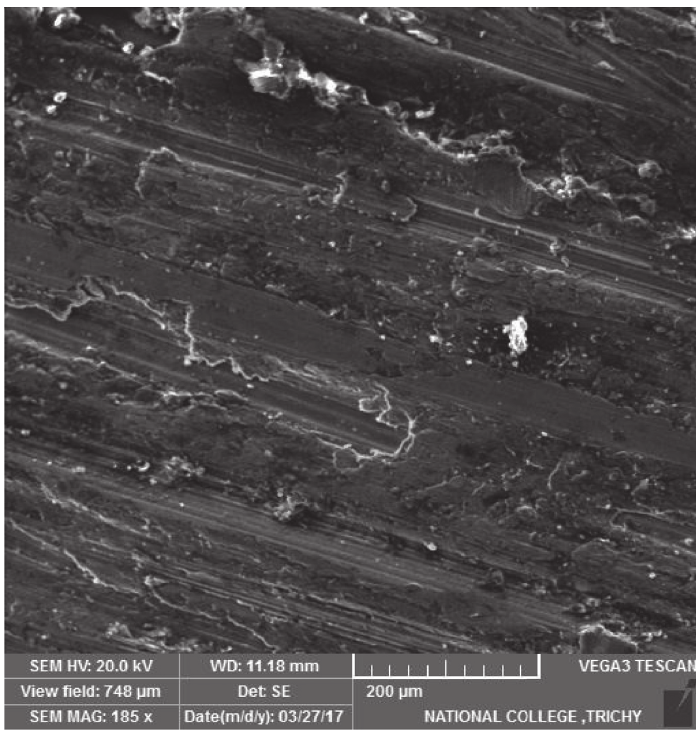
Figure 11: SEM image of Al7075 90% and TiB